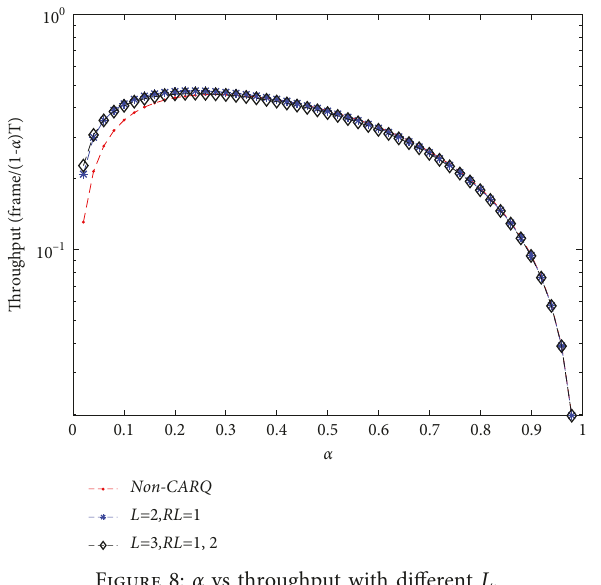
Figure 8: α vs throughput with different L .